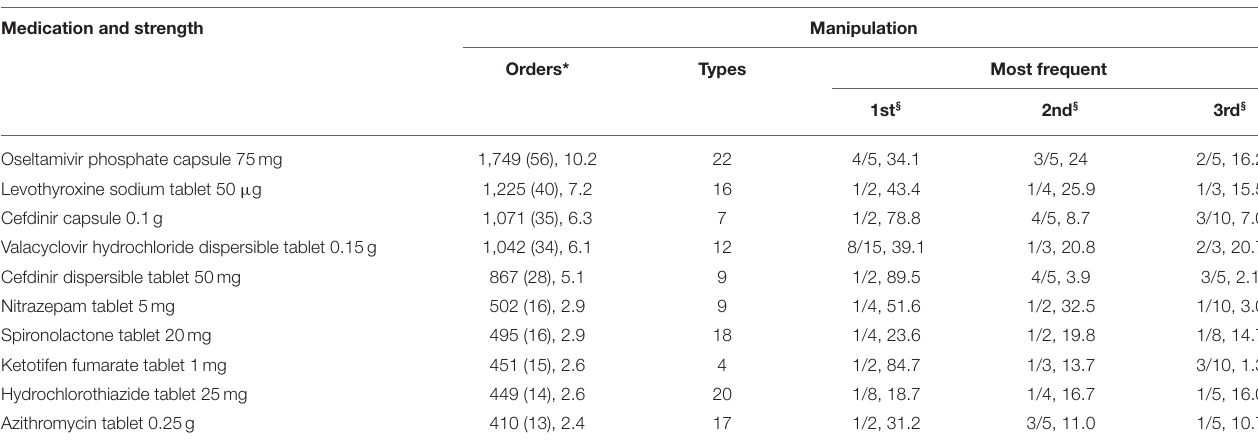
TABLE 1 | The top 10 medicines with most frequent manipulation. Medication and strength